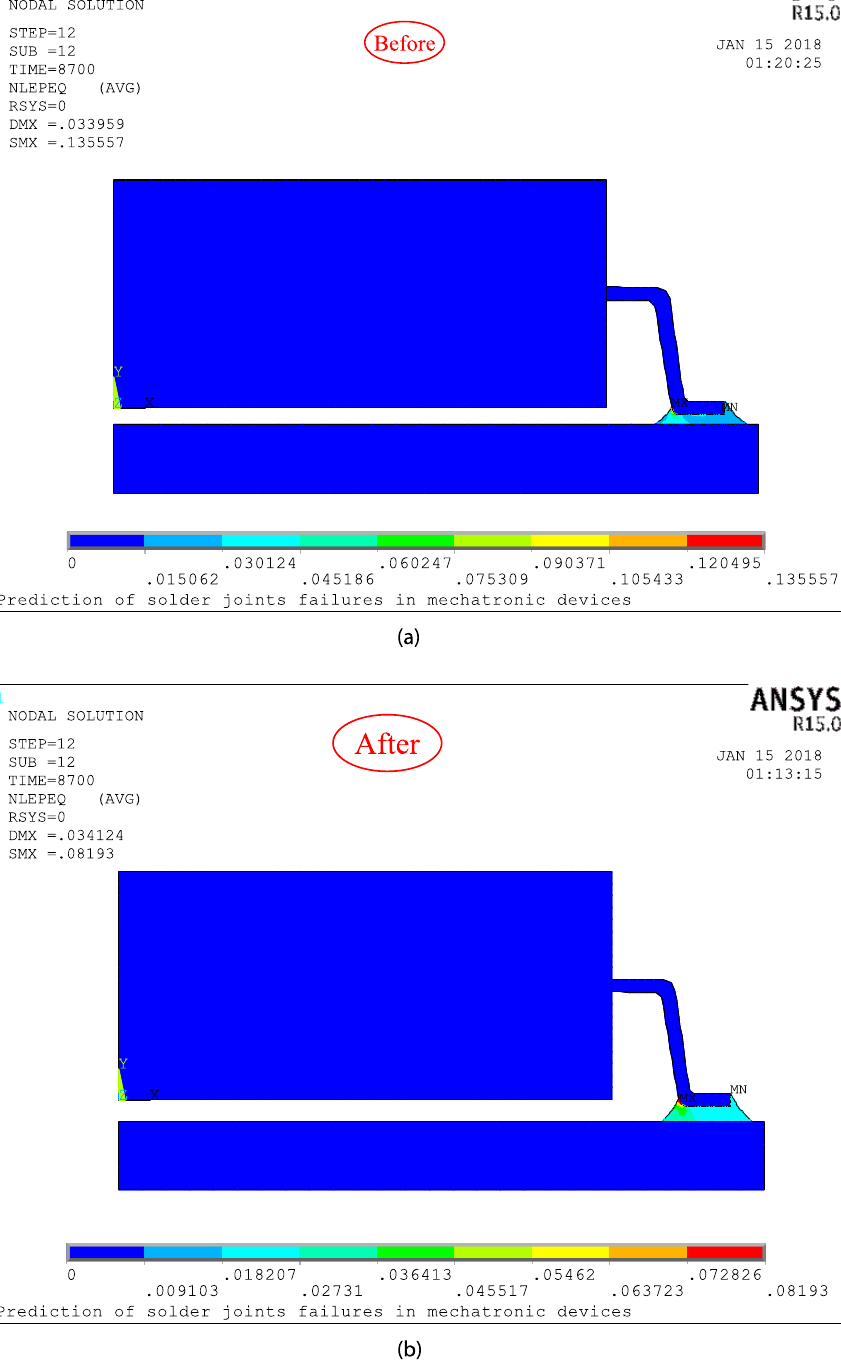
Fig. 11. Strain inelastic distribution before (a) and after (b) optimization